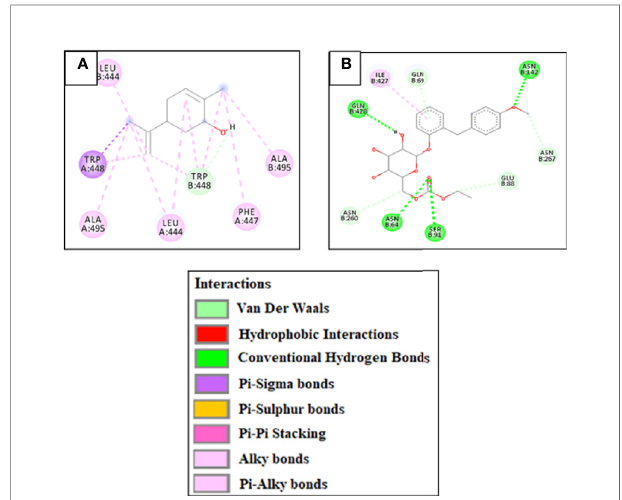
FIGURE 2 | (A) and (B) represent 2D-interactions of carveol and sergli fl ozin with sodium-glucose co-transporter (SGLT), respectively, evaluated through Biovia Discovery Studio